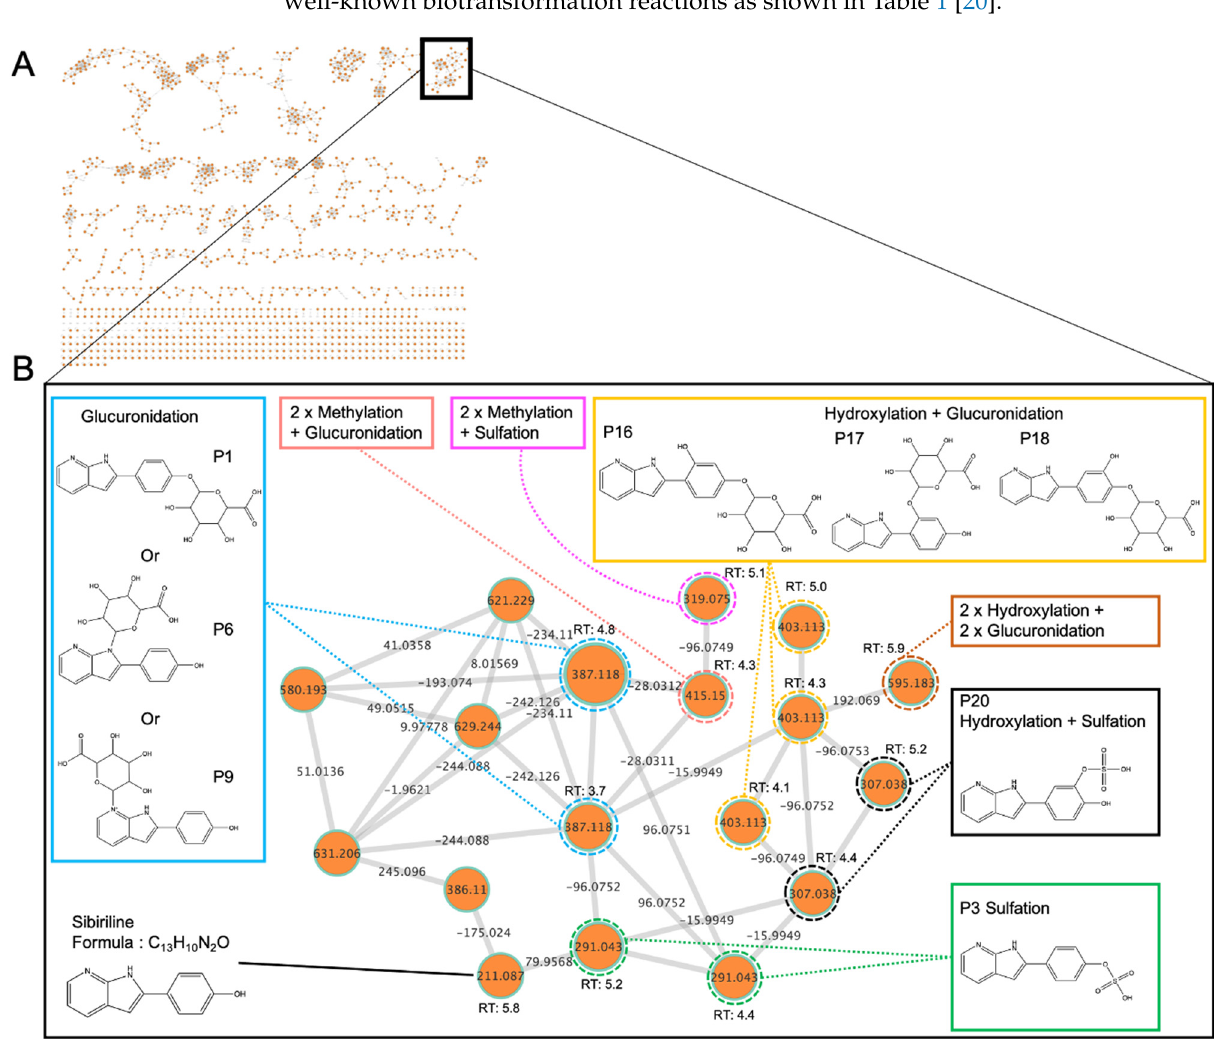
Figure 2. In vitro Sibiriline metabolism. Differentiated HepaRG were incubated with Sibiriline 10 µM during 24 h and culture supernatants were analyzed using LC-HR/MSMS. ( A ) The overall molecular network. ( B ) In this sibiriline-containing cluster, each type of biotransformation reaction was depicted in different colors (glucuronidation in bleu, sulfation in green, oxidation + sulfation in black, oxidation + glucuronidation in yellow, 2 × oxidation + 2 × glucuronidation in orange, methylation + sulfation reaction in pink and methylation + glucuroconjugaison in salmon). Nodes are labelled with the exact protonated mass ( m/z ), retention time (RT) in minute and the links are labelled with the exact mass shift.